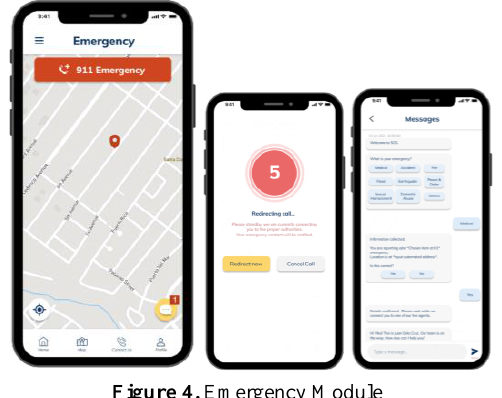
Figure 4. Emergency Module